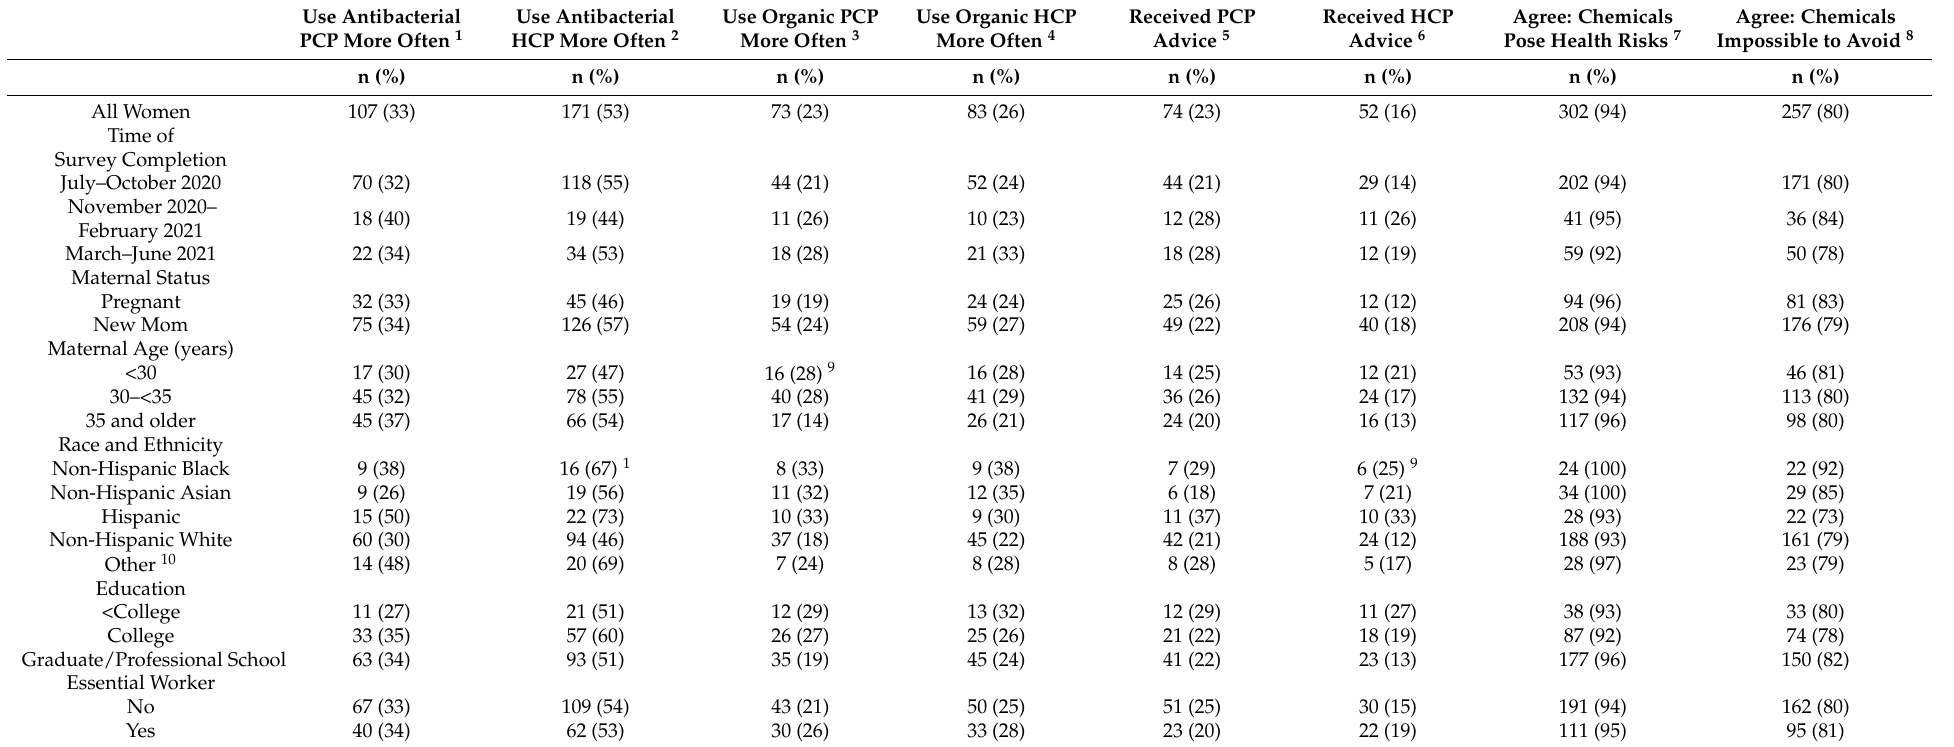
Table 3. Bivariate analyses of change in use of antibacterial and organic personal care products (PCP) and household cleaning products (HCP) during the pandemic, receipt of healthcare provider advice on use of products, and opinions on environmental chemical exposures by selected maternal characteristics among women in the Maternal Health and Behavior Study (n =